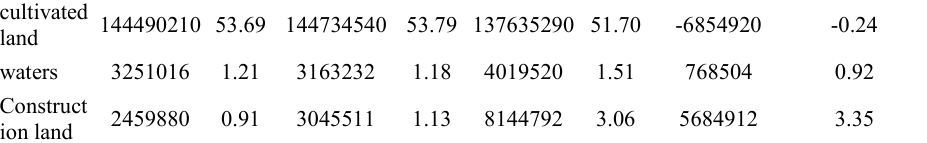
Table 2. Land use transfer matrix of Chengdu-Chongqing Urban agglomeration from 2000 to 2020. year type